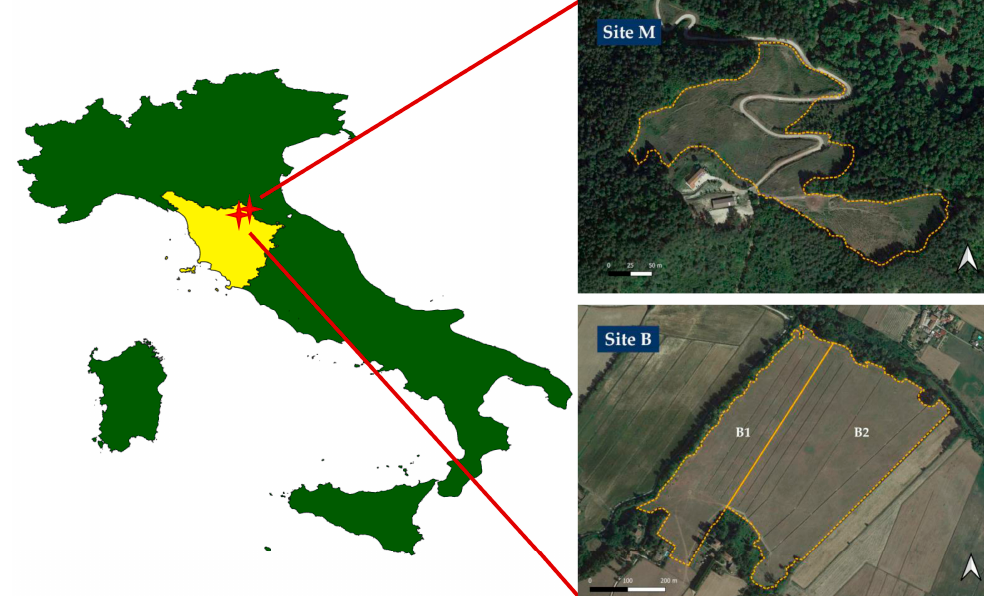
Figure 2. Aerial view of the study sites of Marradi (M, left) and Borgo San Lorenzo (B, right). Satellite images of the sites were obtained from Google Earth.